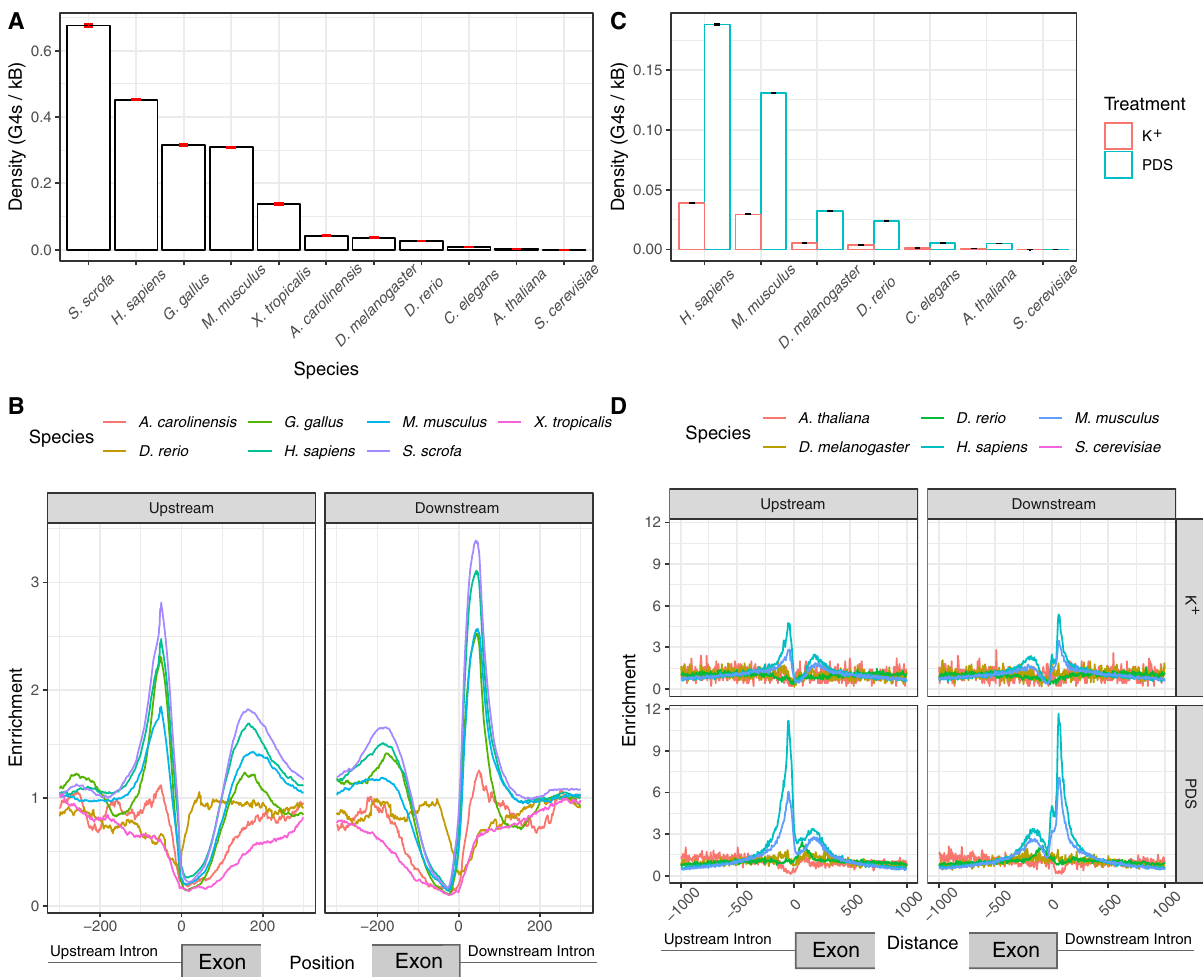
Fig. 7 Enrichment of DNA G4s at splicing sites across different species. A Density of G4 motifs in a 100 nt window on each side across all upstream (3 ’ ss) and downstream (5 ’ ss) splice sites of each species, measured as mean values. Error bars indicate standard deviation from 1000-fold bootstrapping with replacement. B Enrichment of G4 motifs at splice sites for seven vertebrate species, using the consensus G4 motif. C Enrichment of G4-seq derived DNA G4s at splicing sites at 100 nt splicing site windows in PDS and K + treatments, measured as mean values. Error bars indicate standard deviation from 1000-fold bootstrapping with replacement. D Enrichment of DNA G4s at: upstream (3 ’ ss) and downstream (5 ’ ss) splice sites across six species for PDS and K +